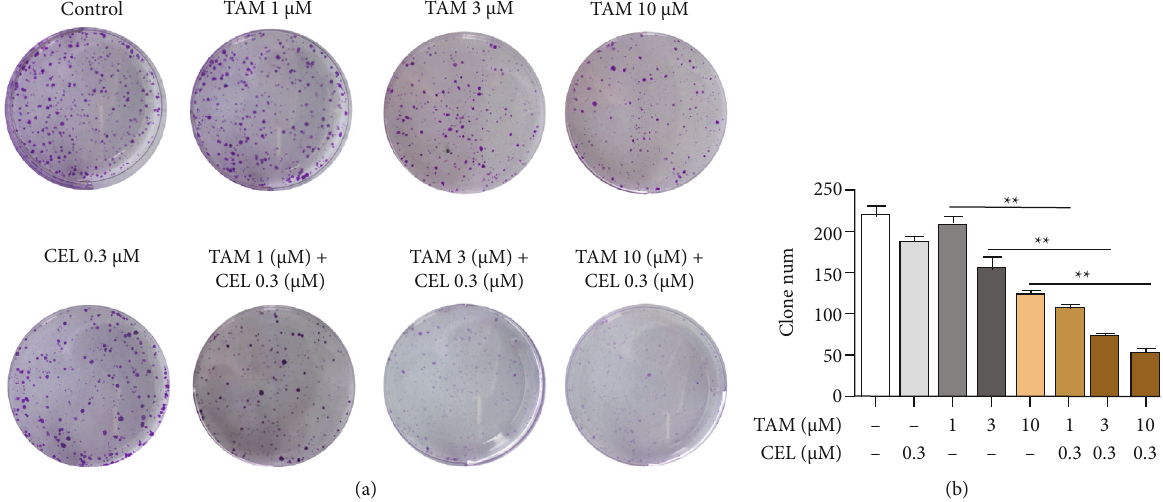
Figure 2: Combination of celastrol and tamoxifen inhibited the colony-forming ability of MCF-7 cells. Tamoxifen a ff ects the colony-forming ability of MCF-7 cells in a dose-dependent manner, and this e ff ect is more pronounced when combined with